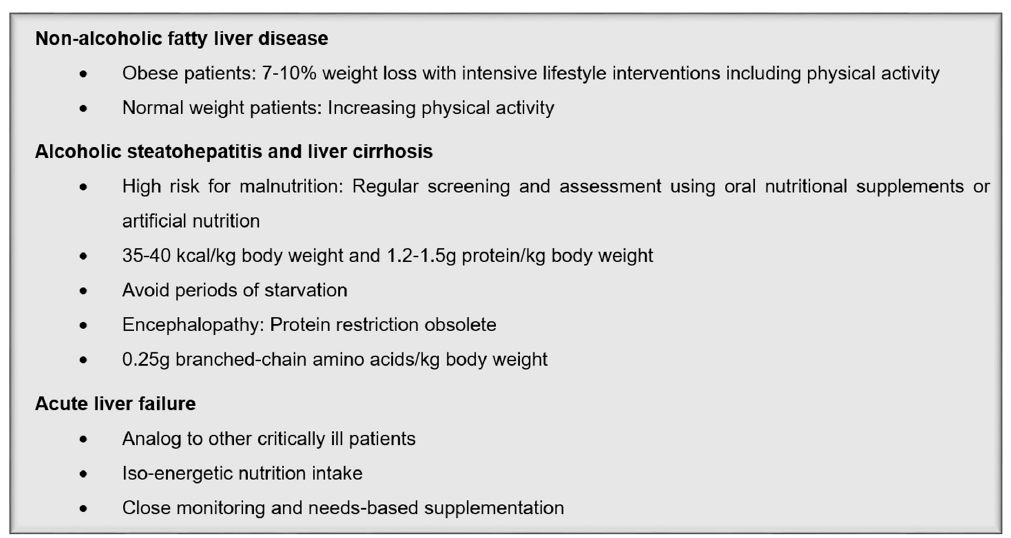
Figure 1. Summary of nutritional recommendations in liver disease.